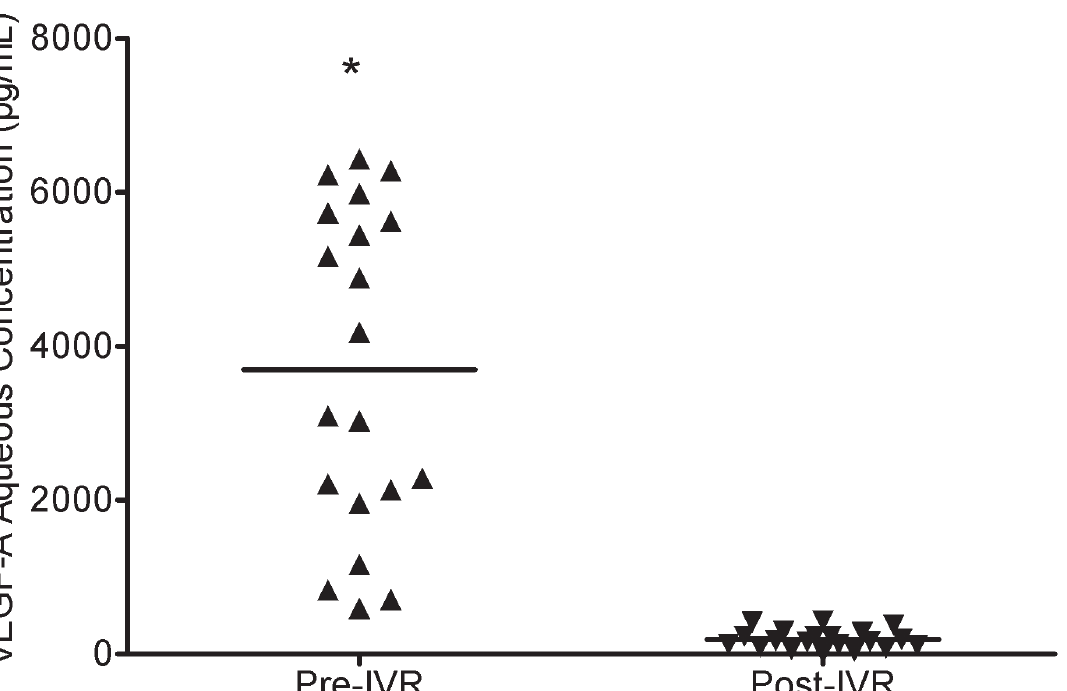
Fig 4. Aqueous humor VEGF-A concentration in the pre-IVR and post-IVR NVG eyes. Compared to pre-IVR, the mean aqueous humor VEGF-A concentration significantly decreased post-IVR in the NVG eyes ( * p < 0.001). Each point represents a measurement from a single patient.